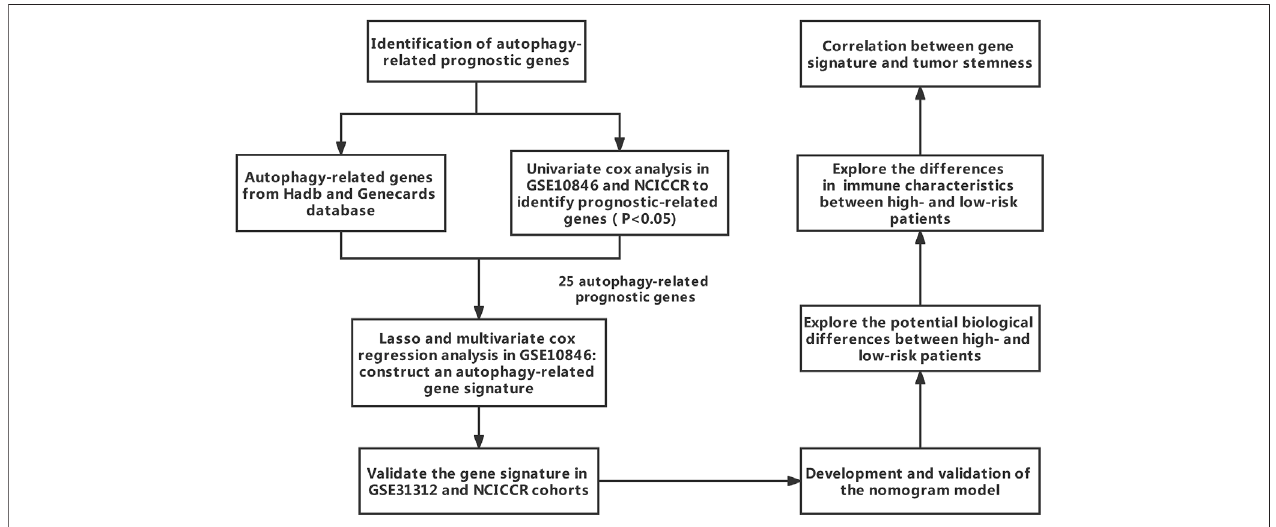
FIGURE 2 | Study fl owchart.